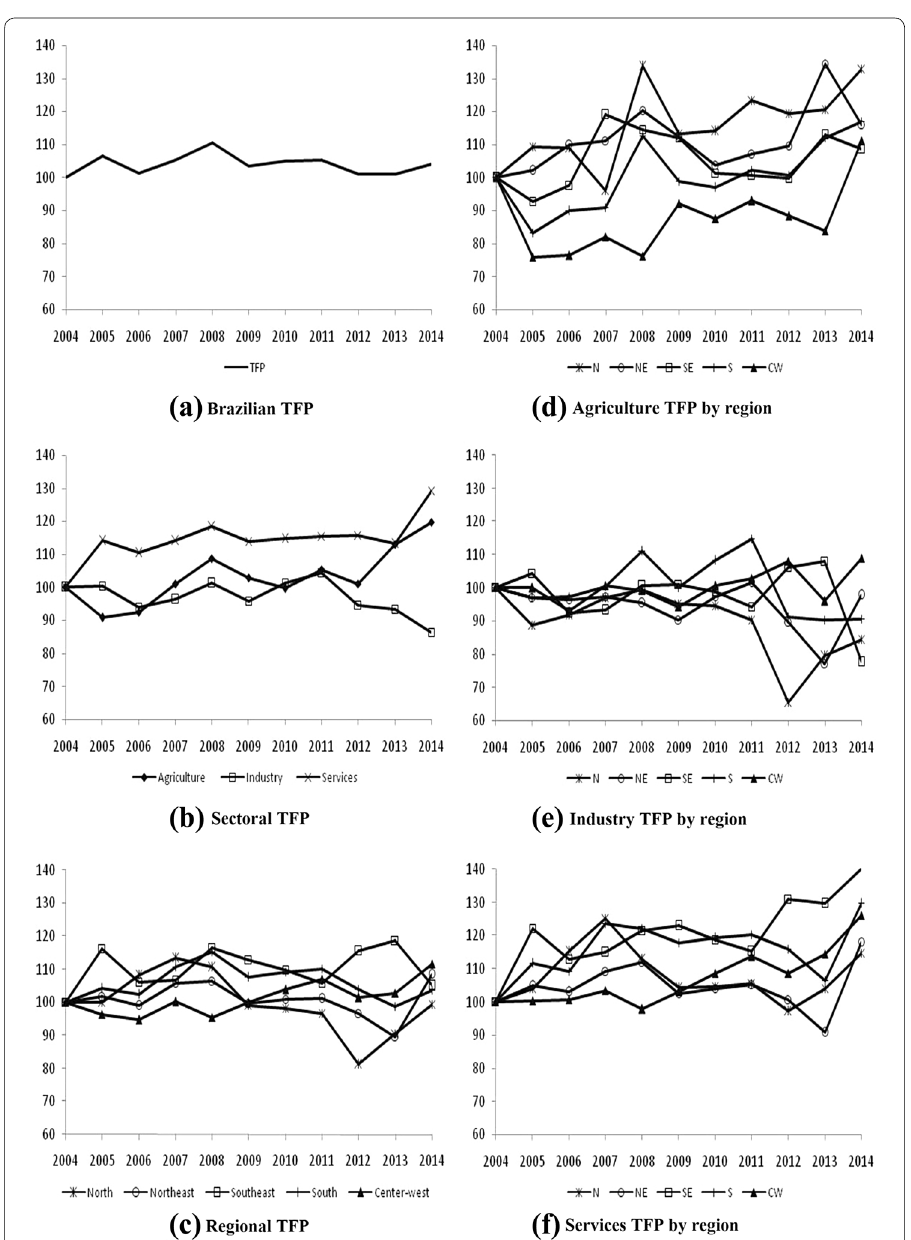
Fig. 1 Productivity index by sector and region in Brazil, 2004–2014. Source: Own elaboration with data of IBGE, BEA, and PNAD